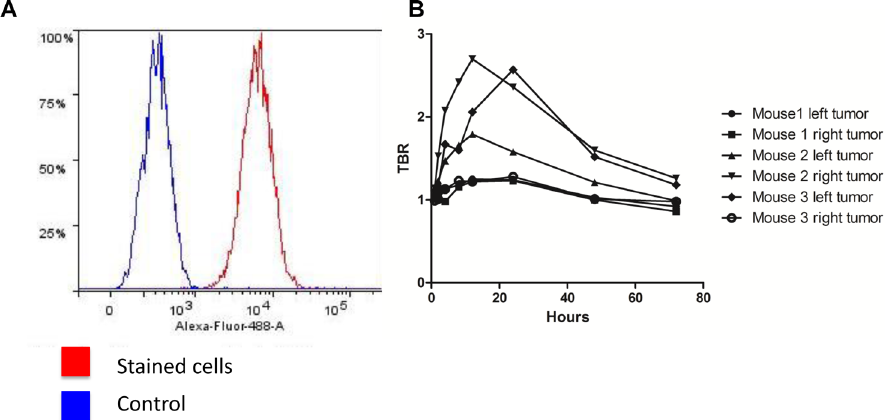
Fig 2. In vitro expression of uPAR in the cell line U87MG and in vivo TBR values over time (1 – 72 h). (A) In vitro flowcytometry confirms the presence of extracellular uPAR on the U87MG cell line with 98.6% positive for uPAR. (B) Dynamic optical imaging of mice with 10 nmol ICG-Glu-Glu-AE105 at the timepoints 1, 2, 4, 8, 12, 24, 48, 72 h. The graph show clear optimum between 6 – 24 h. Each graph represents one of two tumors per